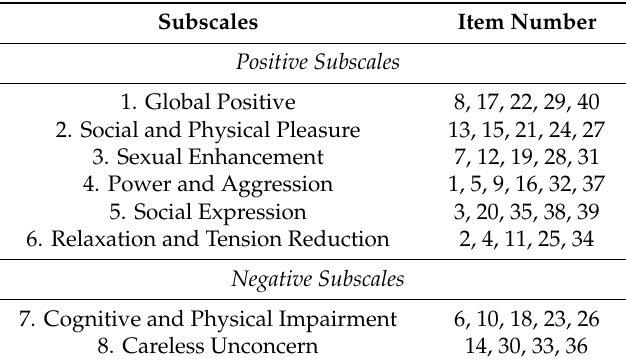
Table 2. Summary of alcohol expectancy